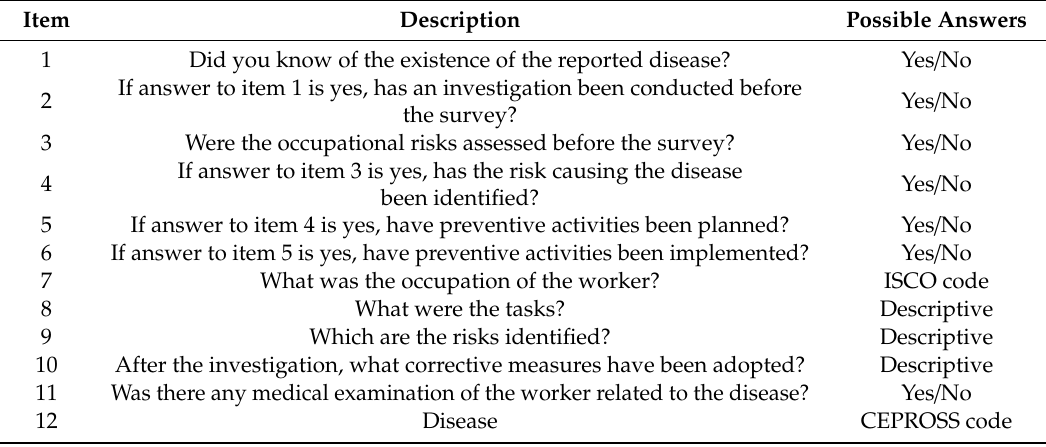
Table 3. Questionnaire used in the survey approved by the Consejo Andaluz de Prevención de Riesgos Laborales.